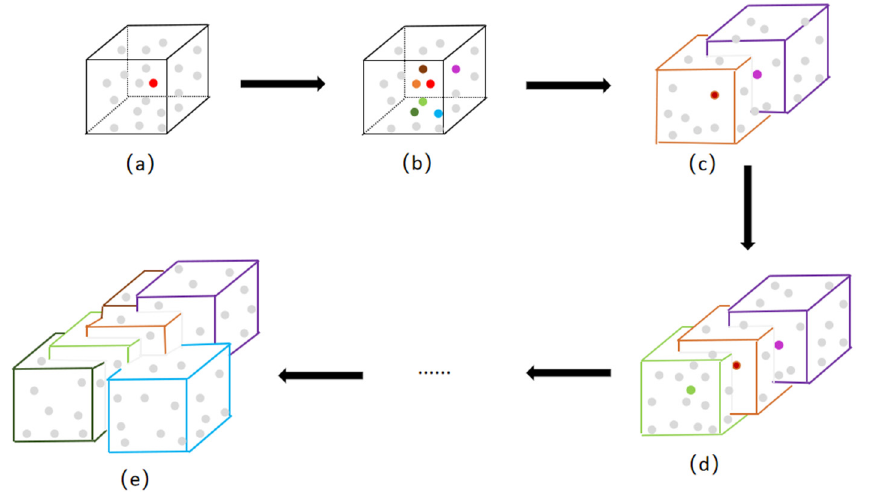
Figure 4. Neighborhood formation process of a red seed point. ( a – e ): non-gray dots: seed points; purple box: the neighboring region with the purple seed point as the center point; the same goes for other colorful boxes.